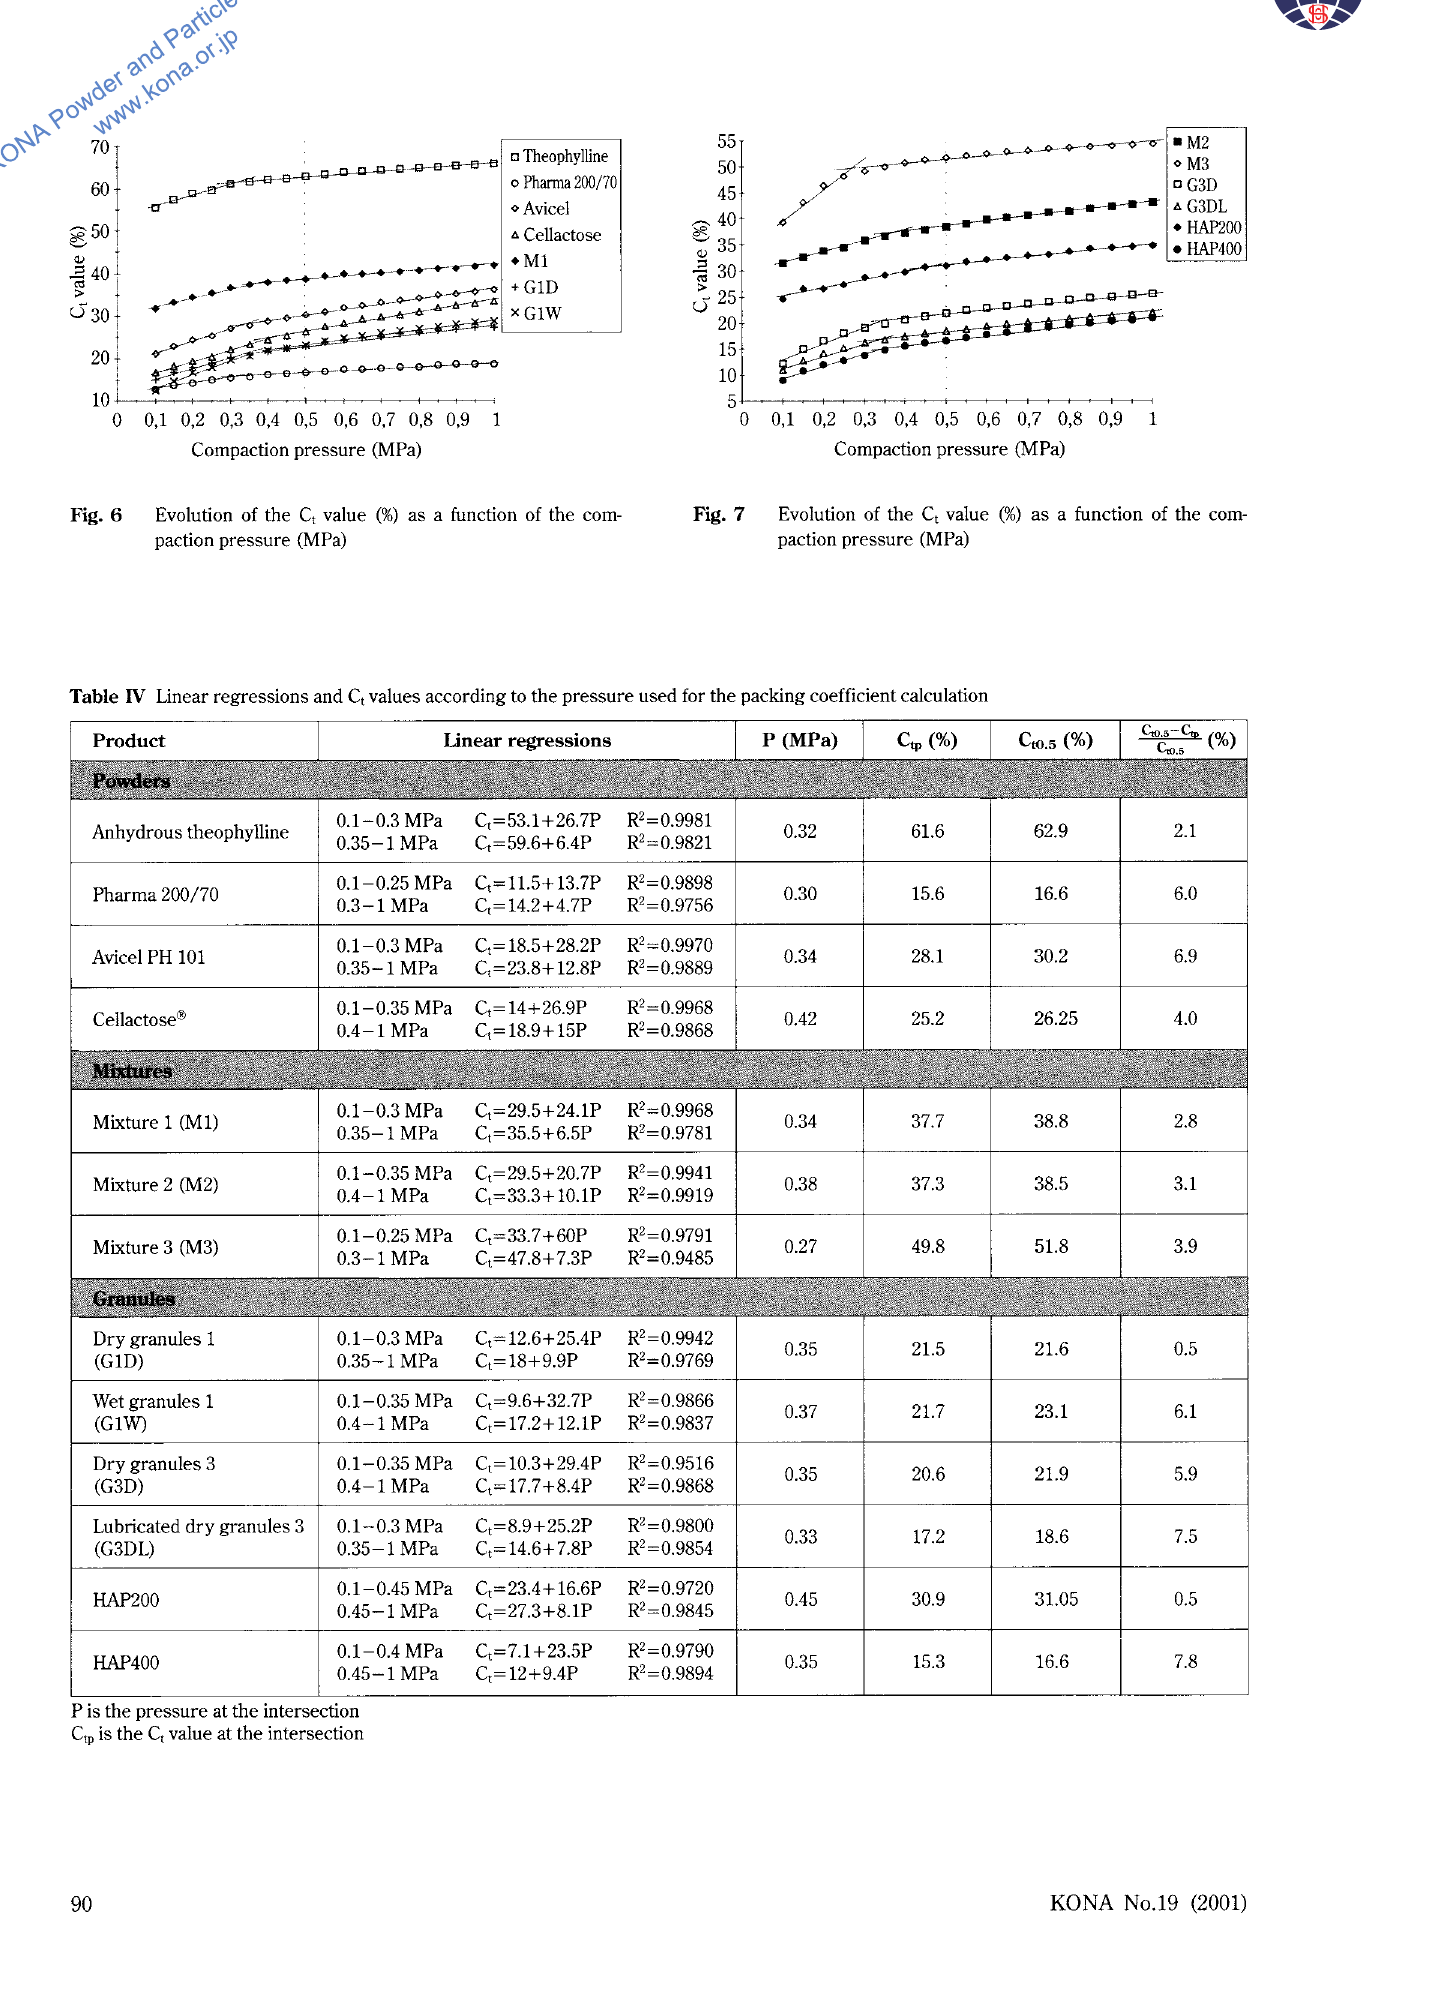
Fig. 6 Evolution of the C, value (%) as a function of the com Fig. 7 Evolution of the C, value (%) as a function of the com